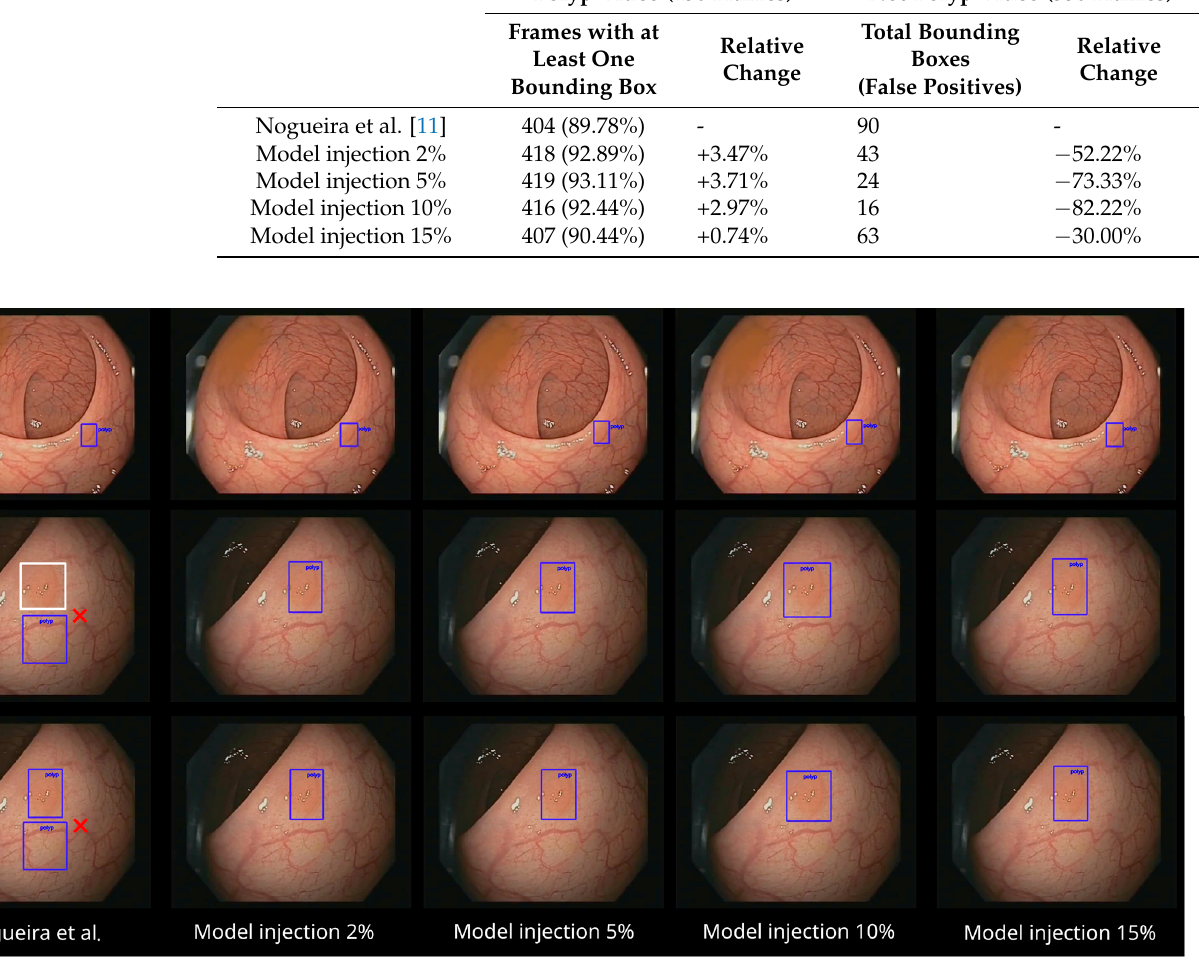
Figure 7. The five models with three sample frames of the polyp video analyzed (Supplementary Video S1). The false positive identifications are marked with red cross marks. The false negatives are marked in white boxes (added manually for illustration purposes)